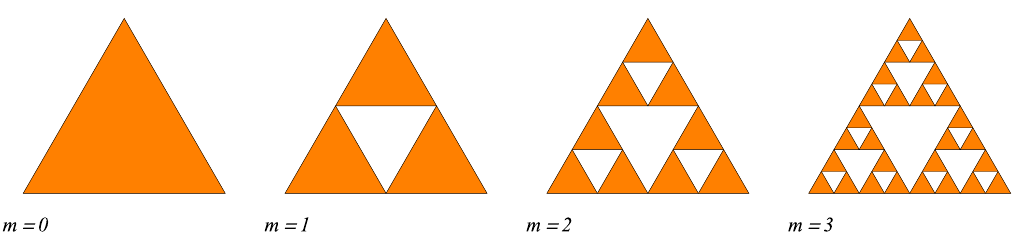
Figure 1. Initiator ( m = 0), and first three ( m = 1,2,3) iterations of the Sierpi´nski triangle